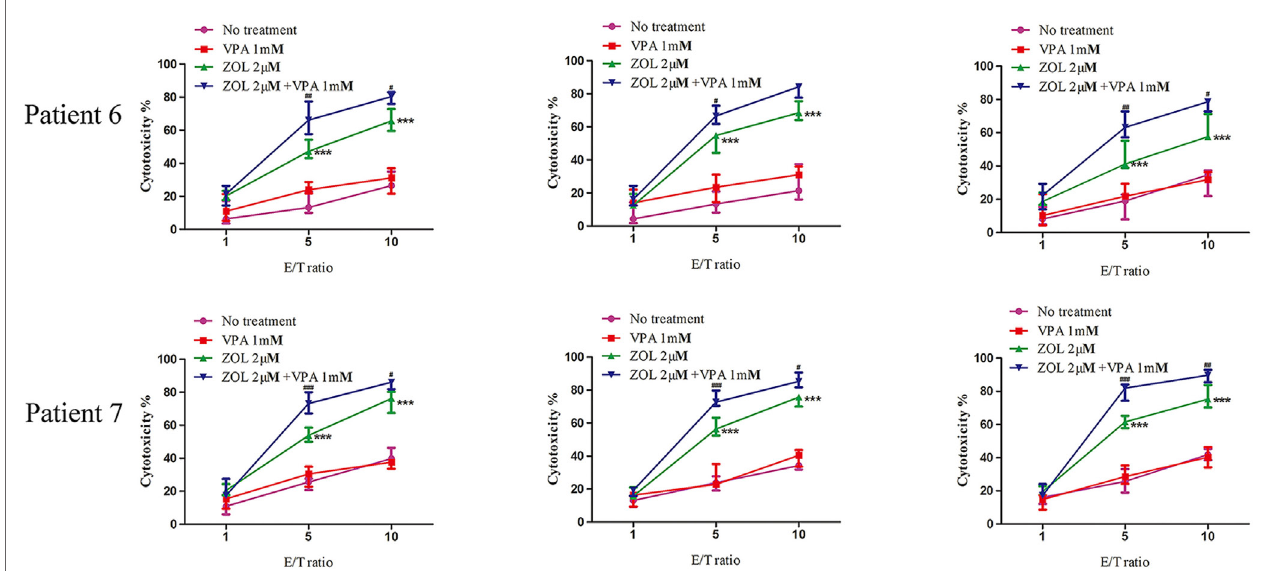
FigUre 7 | Valproic acid and zoledronate (ZOL) enhanced γδ T cells cytotoxicity against osteosarcoma cells in primary cell experiment. HOS and U2OS cells as well as autologous tumor cells were treated with various treatments for 24 h before co-cultured with γδ T cells derived from osteosarcoma patients at the indicated E:T ratios. Cytotoxicity of γδ T cells against tumor cells was evaluated by MTS assay. All the values were shown as mean ± SD; * p < 0.05, ** p < 0.01, *** p < 0.001 versus no pre-treatment, # p < 0.05, ## p < 0.01, ### p < 0.001 versus pre-treatment with